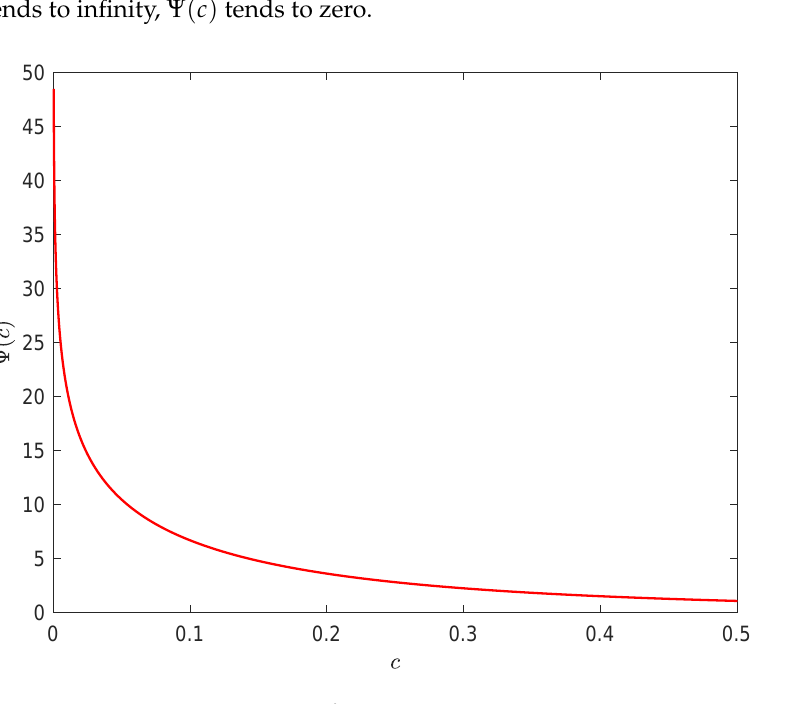
Figure 2. Asymptotic Aggregate